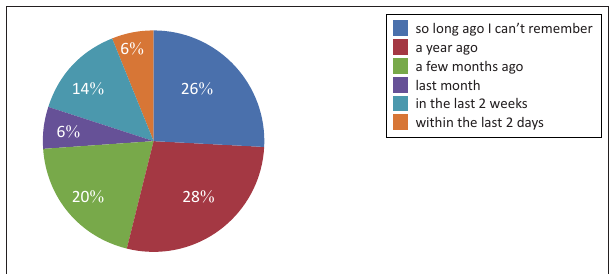
FIGURE 4: When students had read last novel (also named as their favourite). TABLE 2: Relationship between attitude and holiday reading. ‘I love to read’ Percentage of respondents who read an extended text during the holidays ( %